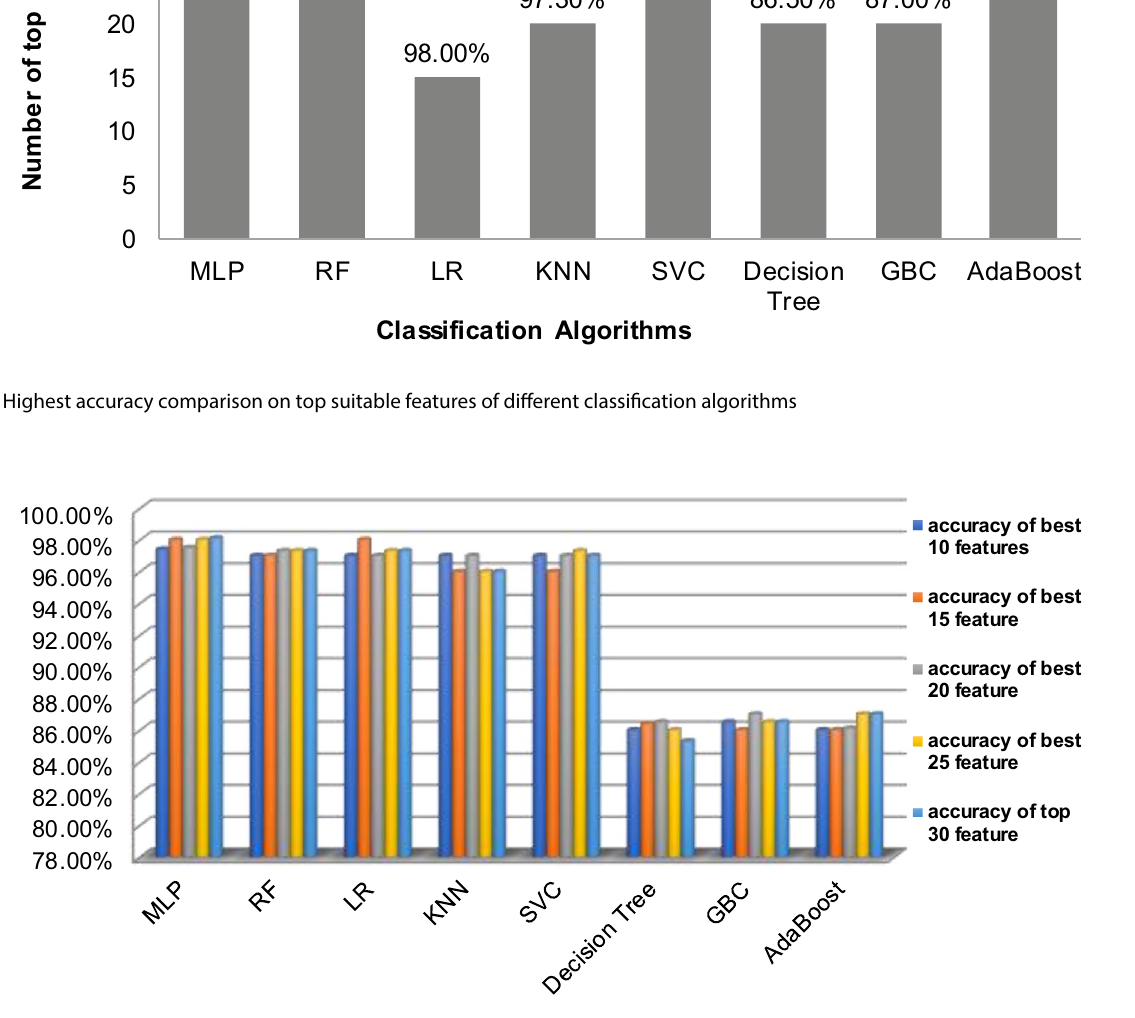
Fig. 12 Highest accuracy comparison on various top features of different classification